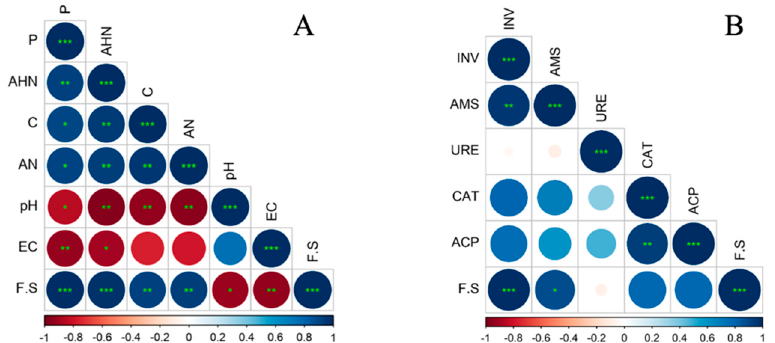
Figure 1. Heatmap of the correlation between the application amount of GLR organic fertilizer and soil physicochemical properties and enzyme activity. Note: ( A ) correlation between the application amount of GLR organic fertilizer and soil physicochemical properties; ( B ) correlation between the application amount of GLR organic fertilizer and enzyme activity; P − available phosphorous; AHN − alkali-hydrolysable nitrogen; C − organic matter; AN − ammonium nitrogen; EC − electrical conductance; F. S − addition of GLR organic fertilizer; INV − invertase activity; URE − urease activity; CAT − catalase activity; ACP − acid phosphomonoesterase activity; AMS − amylase activity; Pearson analysis * ( p < 0.05), ** ( p < 0.01), *** ( p < 0.001). Positive correlation is displayed in blue, and negative correlation is displayed in red. The color intensity and the size of the circle are proportional to the correlation